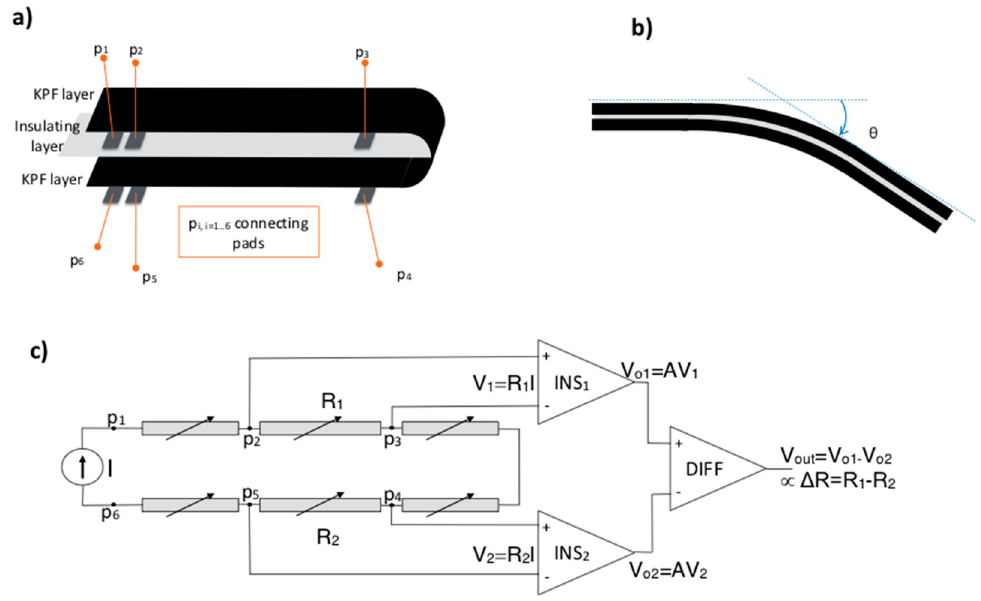
Figure 3. ( a ) Schematic structure of the knitted piezoresistive fabrics (KPF) goniometer. The black stripes represent the two identical piezoresistive layers, while the gray stripe is the insulating layer; ( b ) The output ( ∆ R) is proportional to the bending angle ( θ ) ( c ) KPF goniometer electrical model and block diagram of the electronics front-end. Two instrumentation amplifiers (INS 1 and INS 2 ) and a differential amplifier (DIFF) produce the output ∆ V, which is proportional to ∆ R and thus to ∆ θ .